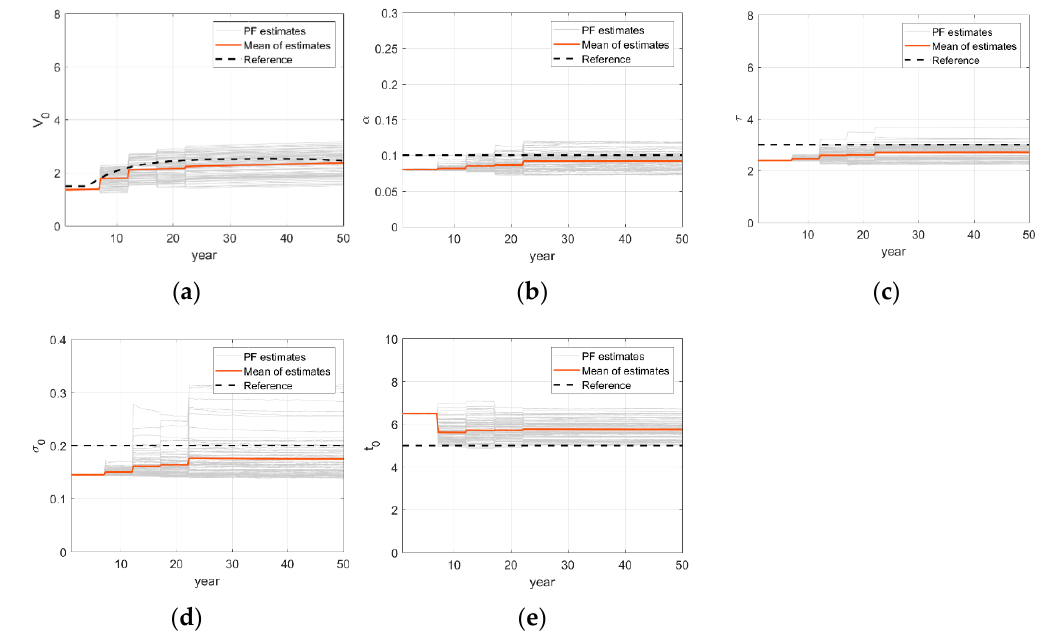
Figure 14. Updating time histories of corrosion model parameters in the presence of a dynamic model parameter: ( a ) Parameter V o ; ( b ) Parameter α ; ( c ) Parameter τ ; ( d ) Parameter σ o ; ( e ) Parameter t o .